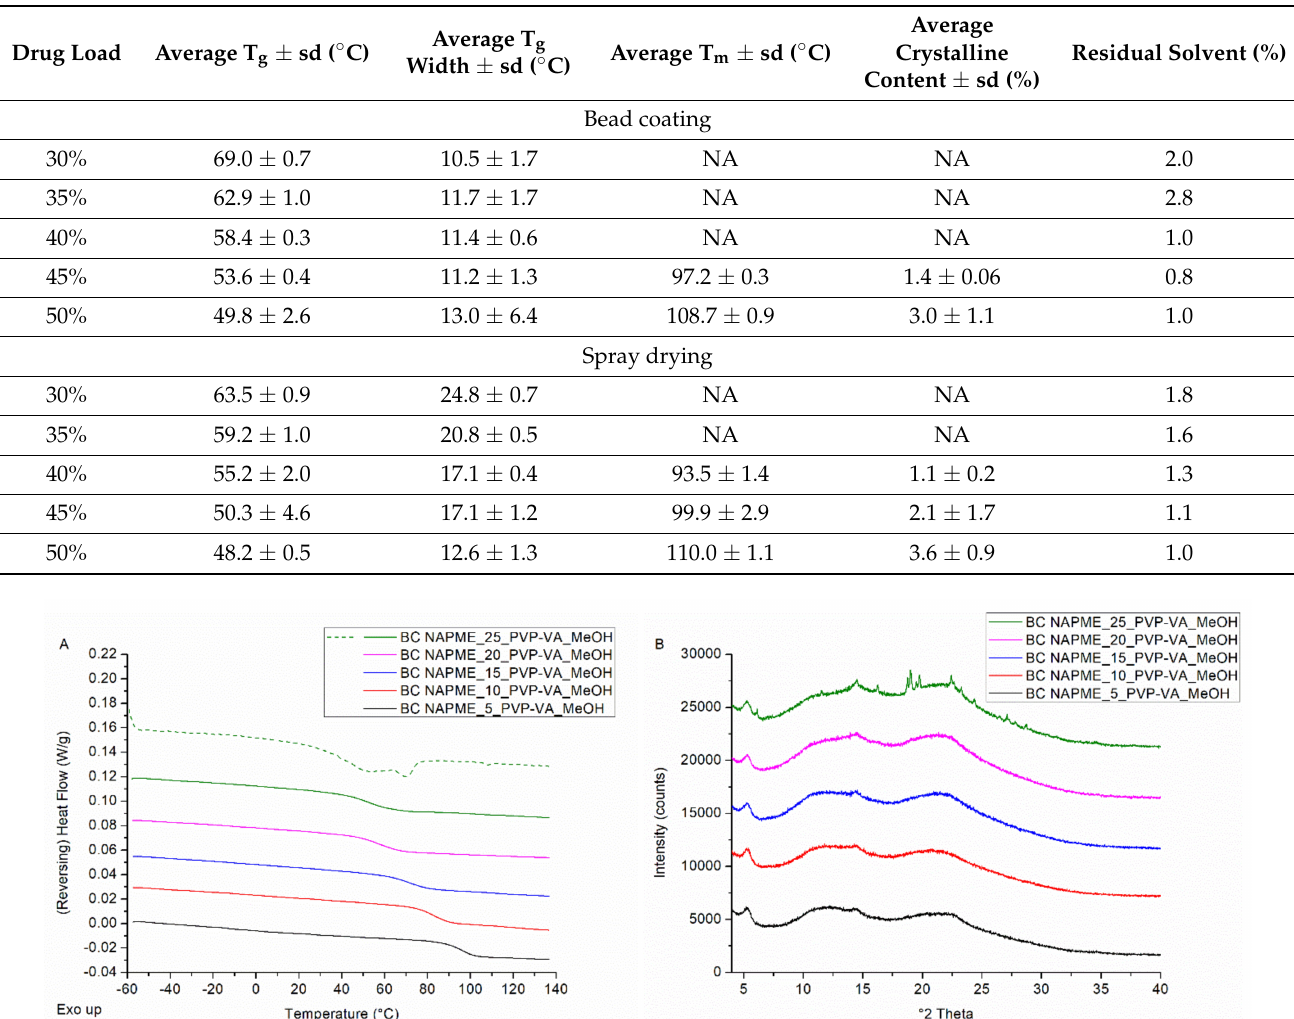
Table 2. Overview of the phase behavior of NAP–PVP-VA formulations prepared with bead coating and spray drying. Average T g s, T g widths, T m values and crystallinity percentages ± sd were obtained from mDSC measurements. Residual solvent percentages were derived from TGA analyses. NA = not applicable. The T g of pure PVP-VA was determined to be 110.3 ◦ C (second heating cycle), while the T g of pure NAP is reported to be 5 ◦ C [36].